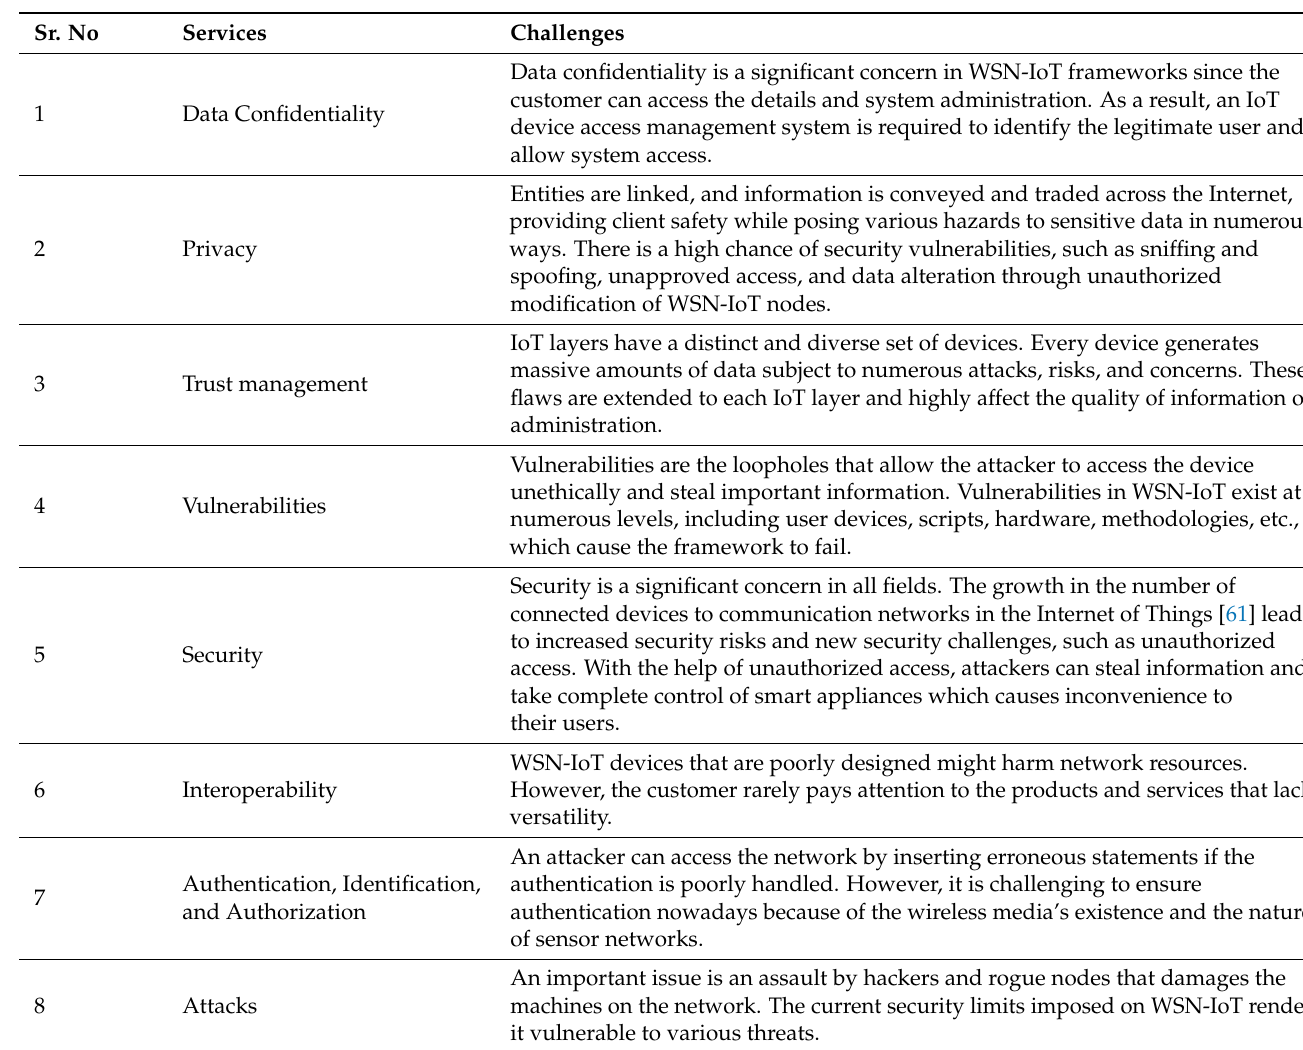
Table 3. Security challenges in